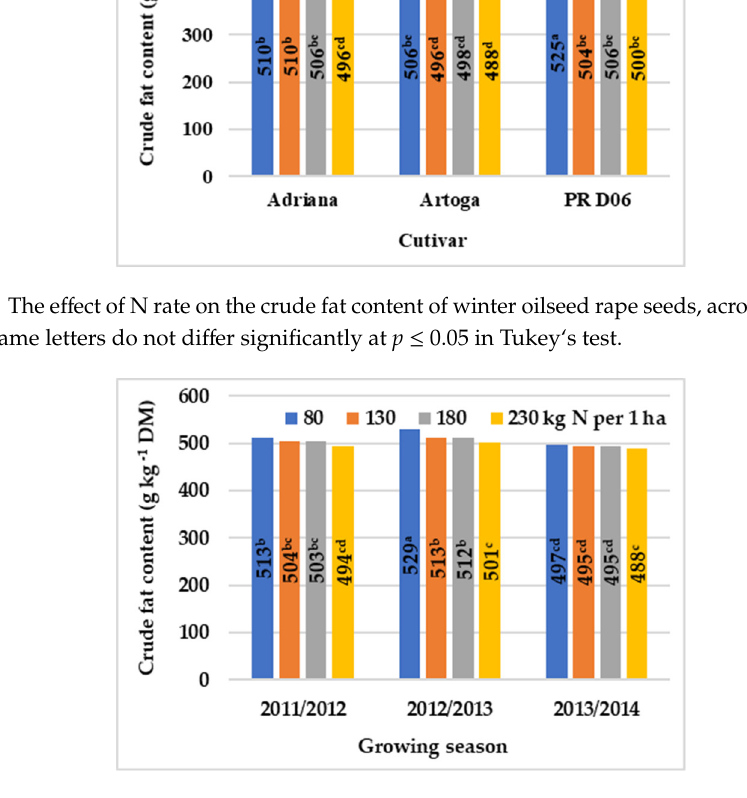
Figure 12. The effect of N and sulfur (S) rates on the total protein content of winter oilseed rape seeds, across years. Means with the same letters do not differ significantly at p ≤ 0.05 in Tukey`s test. Long-stem cultivars (Adriana and Artoga) accumulated 34–39% more GLS than the semi-dwarf hybrid cultivar (PR44 D06) (Table 6). In long-stem cultivars, N rates up to 180 kg ha −1 decreased GLS content by 7–8%, whereas higher N rates increased GLS content by 7–11%. The GLS content of seeds in the semi-dwarf hybrid cultivar was not significantly modified by N fertilization (Figure 13). Sulfur fertilization rates of 40 kg ha −1 and 80 kg ha −1 increased GLS levels by 19% and 29%, respectively (Table 6). The GLS content of seeds in long-stem cultivars increased up to the S rate of 80 kg S ha −1 and it was 1.4-fold higher in the hybrid cultivar than in the open-pollinated cultivar (2.6 μM g −1 DM